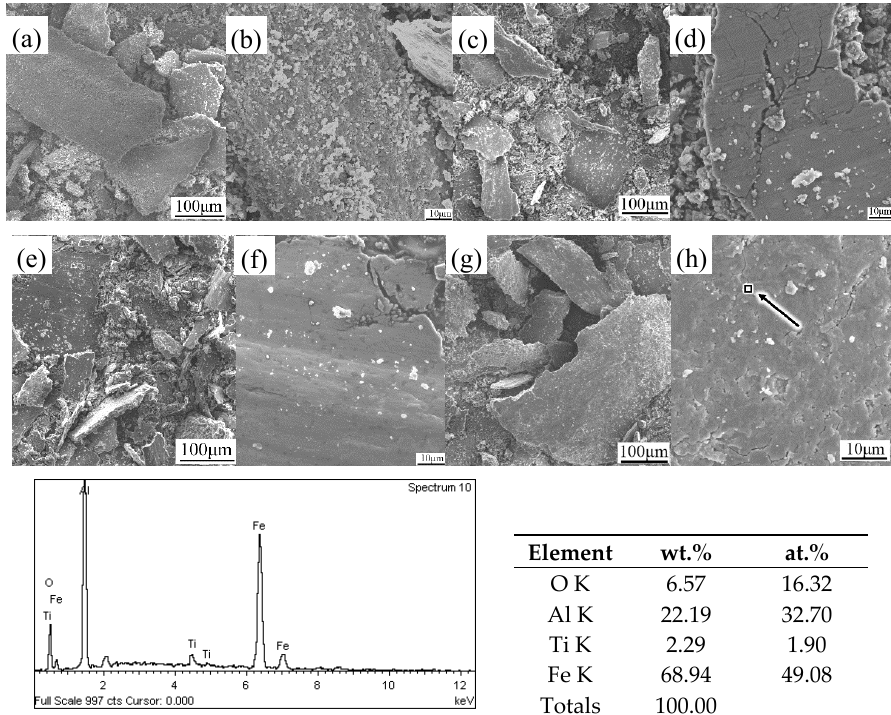
Figure 13. SEM and EDS results of the wear debris on rheocast 4.5 wt. % TiB 2 /7075 specimens formed under different friction loads: ( a , b ) 30 N, ( c , d ) 60 N, ( e , f ) 90 N, and ( g , h ) 120 N.